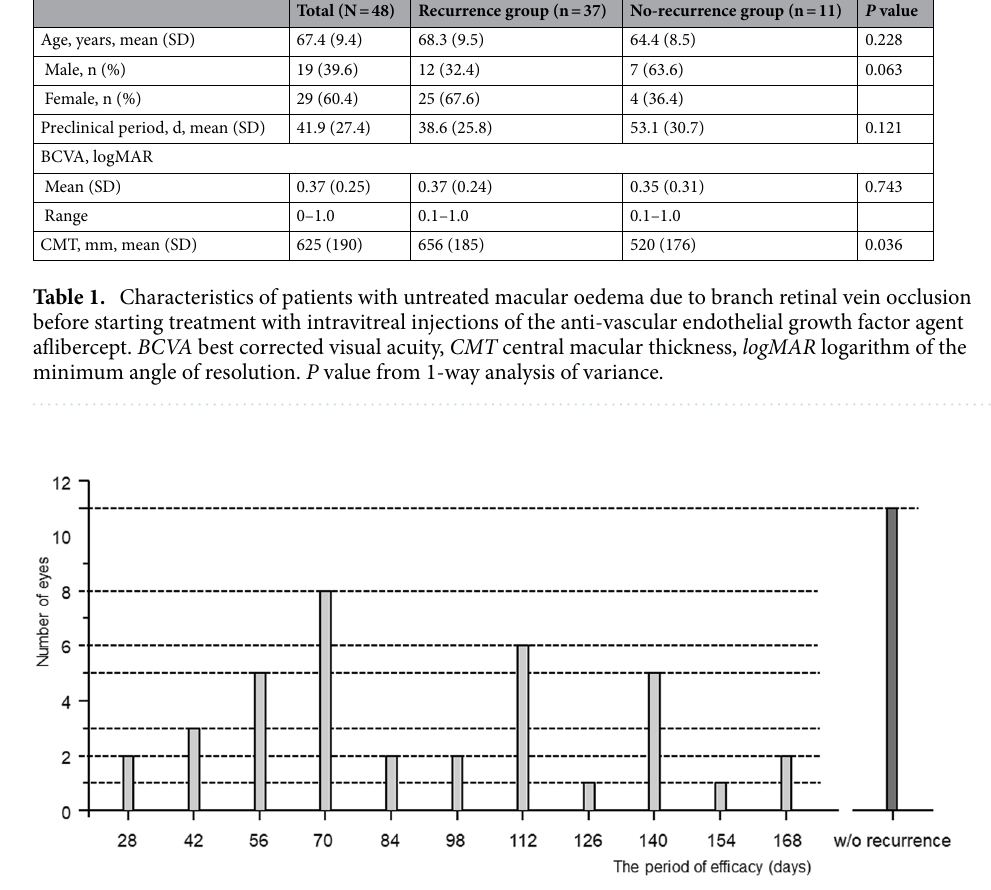
Figure 1. The number of eyes according to the period of efficacy. The period of efficacy appeared to show a bimodal pattern, with a group of participants showing recurrence before 12 weeks and one showing recurrence after 16 weeks. Eleven eyes showed no